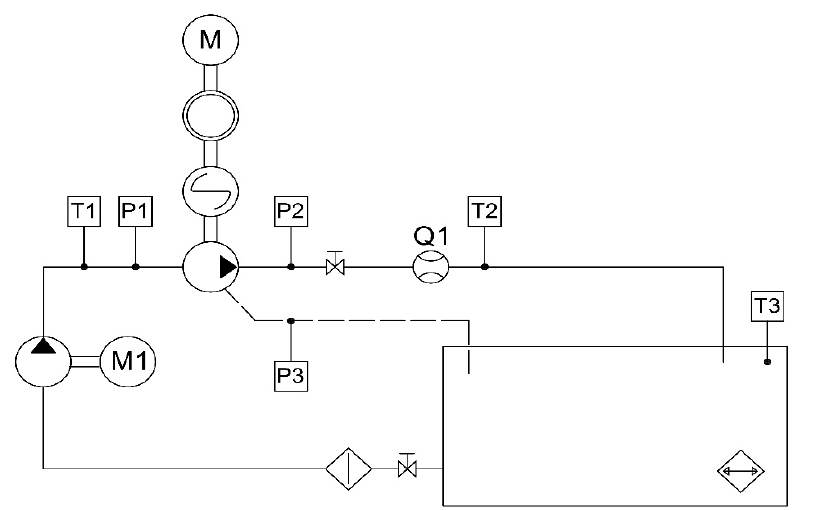
Figure 2. ISO test installation scheme. Table 1. Sensors and equipment used in the experimental test installation.